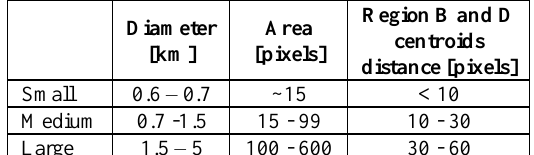
Figure 8. The example of final results. Illuminated, B region – green; shaded, D region – red. (a) small structures, (b) medium structures, (c) large structures Based on the criterion of the minimal distance and mutual orientation, the obtained results, i.e. B and D regions, were saved in a form of matrix. Each of the detected pair of B and D regions has a separate, unique label. This record makes it easy to identify shaded and illuminated areas of the same crater. The geometrically determined center of the detected crater has been design as the geometrical center of the line connecting the centroid of the B and D region. The point, with coordinates corresponding to the geometrical center of the detected crater is simply its marker in the resulting database. This marker is counted for the entire analysed area, creating a database of the automatically detected impact craters. Each of the detected manually and automatically craters was assigned automatically to one of three size groups that meet the parameters described in Table 3. The final results of the semi-automatic detection of impact craters with respect to the size of detected structures are presented in Table 4.